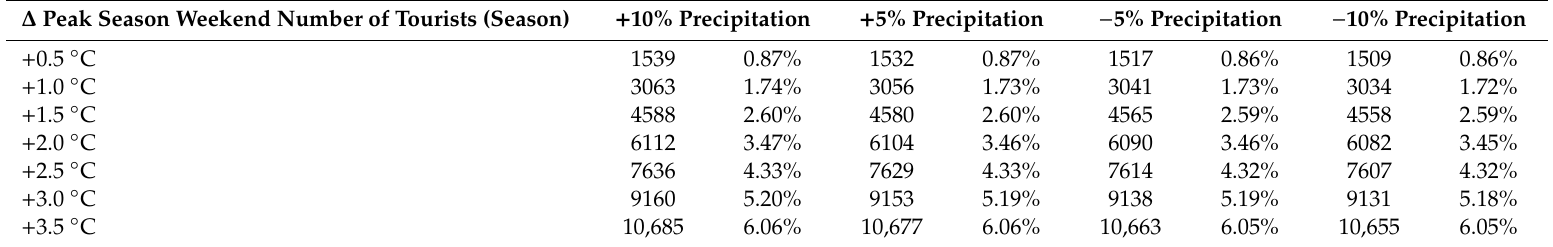
Table 10. Peak season number of weekend tourists increase (persons per season) and increate rate (%). ∆ Peak Season Weekend Number of Tourists (Season)